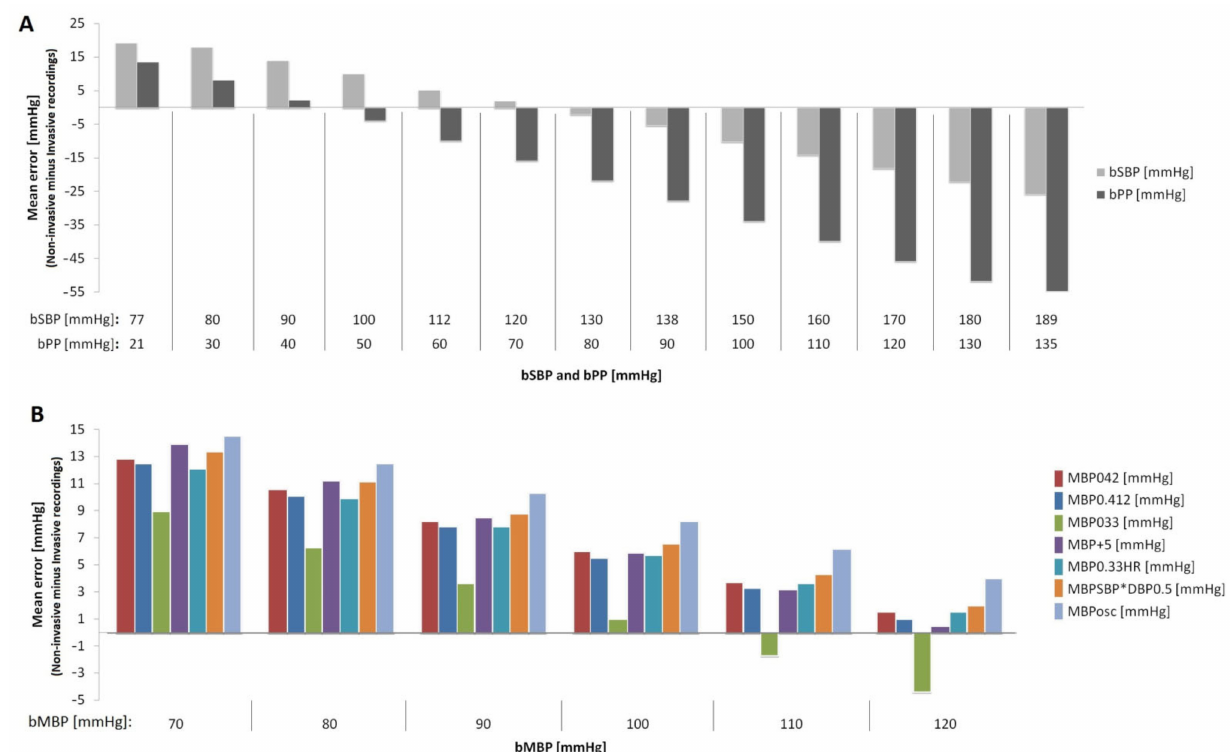
Figure 2. ( A ): Errors between invasive and oscillometric bSBP and bPP data for different BP levels. ( B ): Errors between invasive bMBP data and non-invasive bMBP data obtained considering several calibration schemes and different BP levels. HR: heart rate. Osc: oscillometric